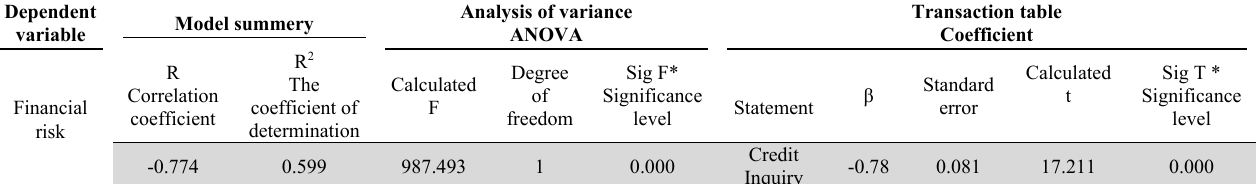
Results of the simple regression test for the effect of credit reporting on financial credit risks Dependent variable